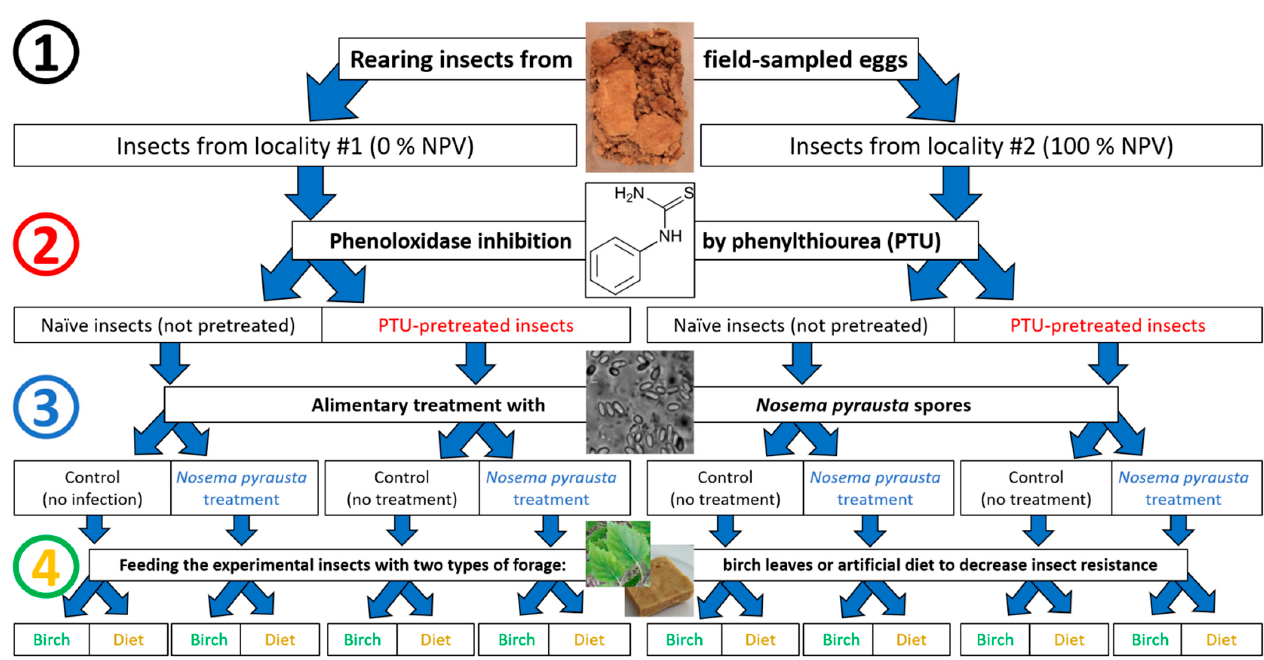
Figure 1. Experimental scheme showing the four stages of insect manipulation, corresponding to the four factors examined: ( 1 ) sampling from two localities, ( 2 ) pretreatment with phenylthiourea (PTU) or no pretreatment (naïve), ( 3 ) treatment with microsporidia or no treatment (control) and ( 4 ) feeding either with fresh birch leaves or an artificial diet.